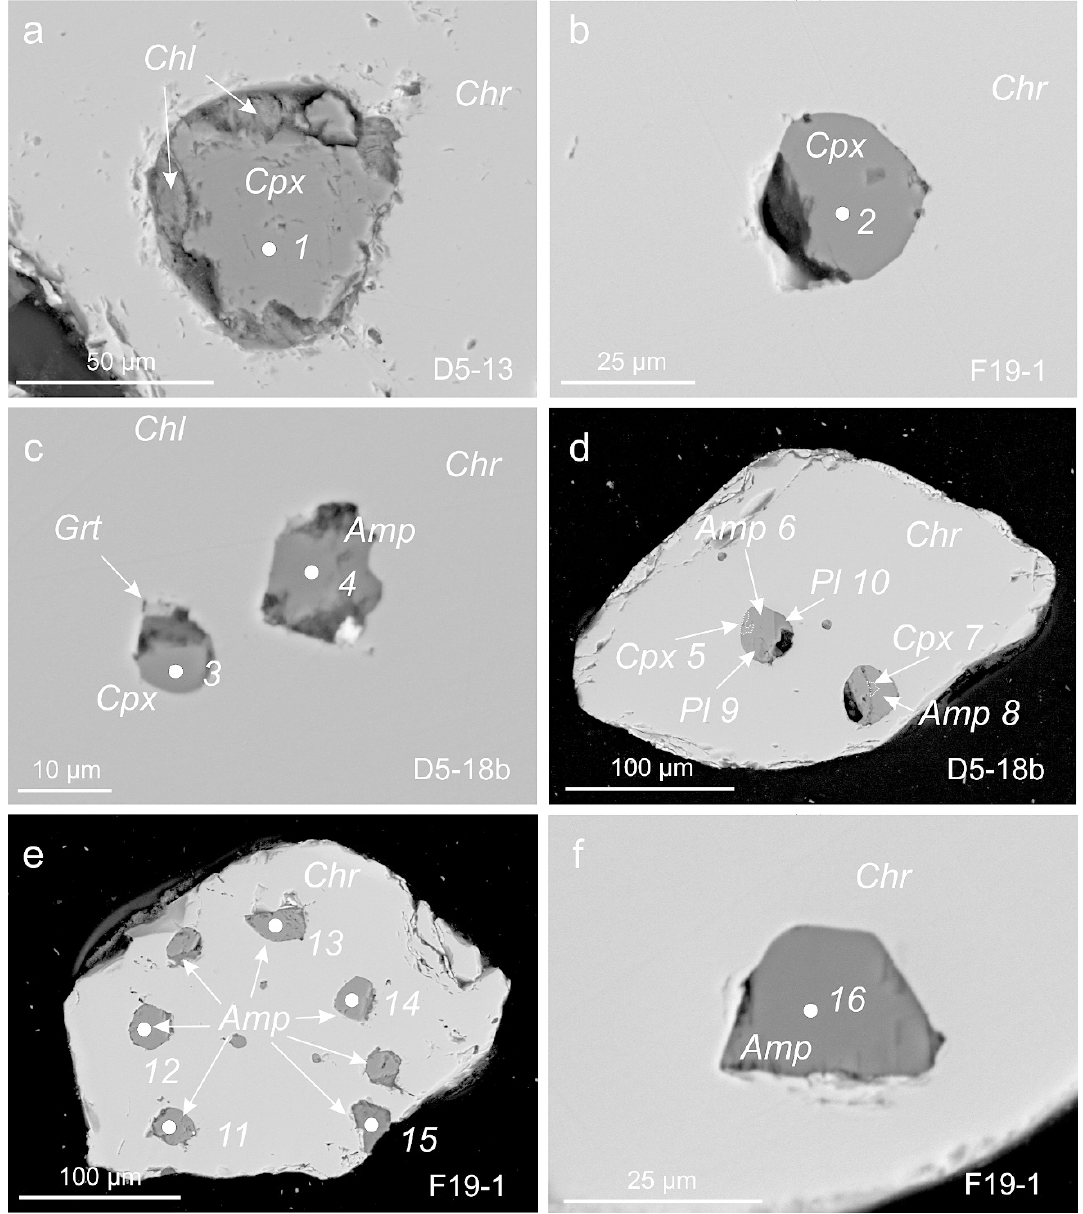
Figure 13. BSE images of monomineralic and polymineralic clinopyroxene (Cpx) and amphibole (Amp) inclusions in chromspinels (Chr) from the Sabantuy paleoplacer (samples D 5 -13, D 5 -18b, F 19 -1): ( a , b ) clinopyroxene inclusions partially replaced by chlorite (Chl); ( c , d ) polymineralic inclusions in chromite. Grt—Ca-rich garnet; ( e ) abundant amphibole inclusions in chromite; ( f ) single amphibole inclusion. Note: the numbers indicate the points of the compositions presented in Table 4. Table 4. The composition of monomineralic and polymineralic clinopyroxene–amphibole–plagioclase inclusions in chromite (wt.%).